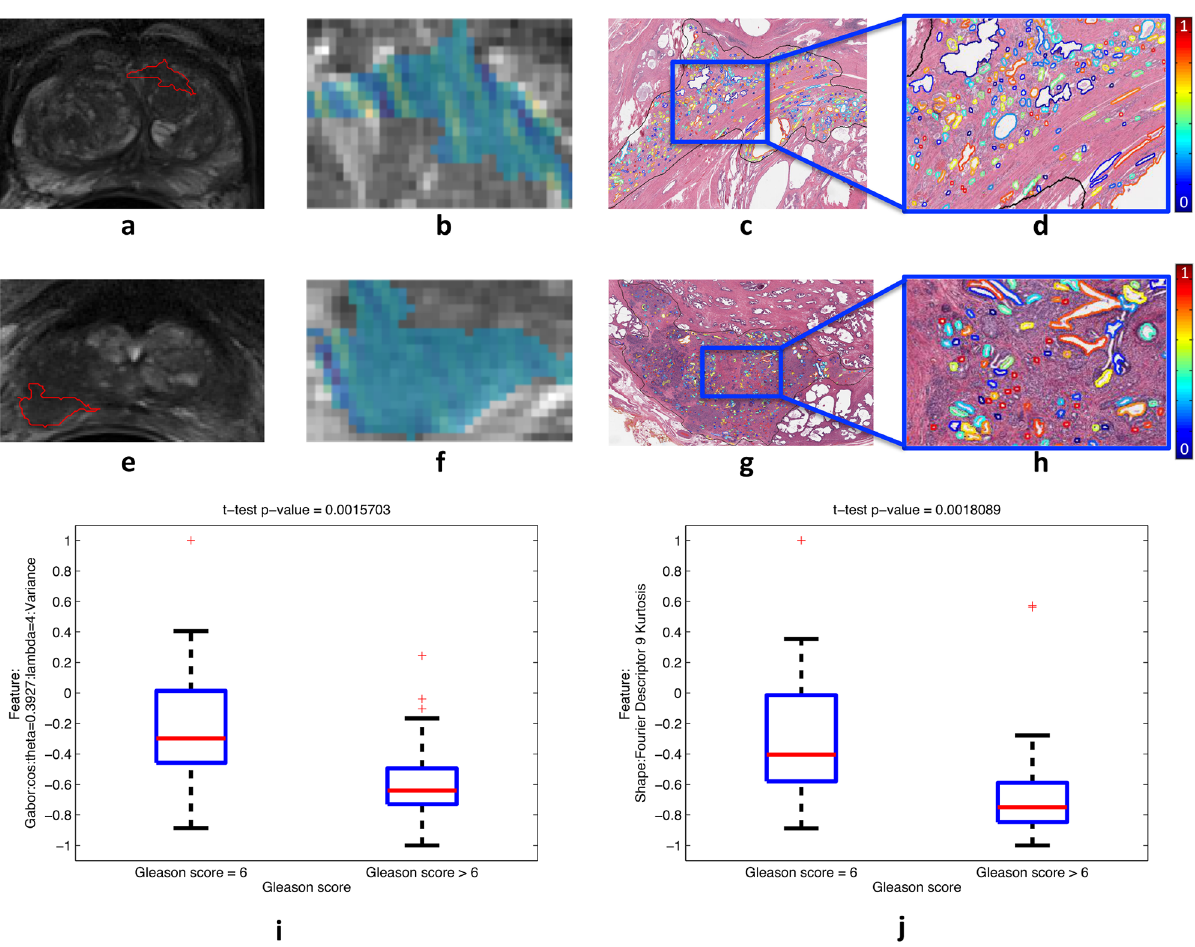
Fig 6. Differential expression for a pair of strongly correlated and discriminating radiomic and QH features between tumors with Gleason score 6 (a-d) and Gleason score 9 (e-h) from D 1 . The radiomic feature values are plotted within the tumor (blue = low values, yellow = high values) shown within the whole prostate (a,e) as well as zoomed-in (b,f). The corresponding QH feature values are plotted within the tumor region on the segmented gland lumen boundaries (blue = low values, red = high values), shown within the whole tumor (c,g) as well as zoomed-in (d,h). Boxplots summarizing the differential expression of these features over all tumors from D 1 (N = 65) are plotted (i, r). Note the low number of colors in the tumor with high (f) relative to low (b) Gleason score, indicating lower variance of the depicted Gabor feature within the high Gleason score tumor. Additionally, note the greater number of colors in the tumor with high (h) relative to low (d) Gleason score, indicating lower kurtosis of the depicted shape feature within the high Gleason score tumor.